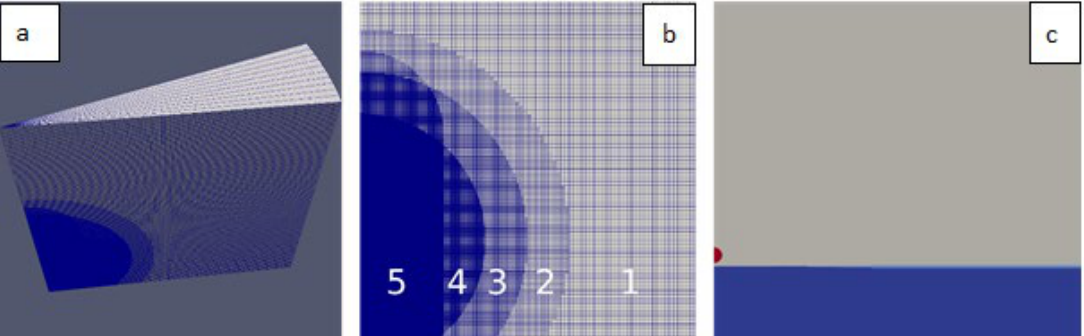
Figure 2. Numerical mesh used in the study: ( a ) overview of the whole wedge mesh; ( b ) cross-section through the central part (40 × 40 mm)—fragment showing refinement areas (numbered: 1, 2, 3, 4, and 5); ( c ) configuration of simulated fluid at the initial time (fluids: air—grey, water— blue, petrol— red).